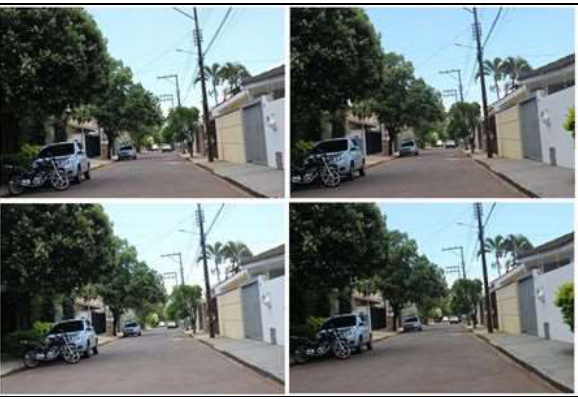
Figure 2 – The first two pairs: horizontal – pairs 1-2, 3-4; vertical: pairs 1-3, 2-4.